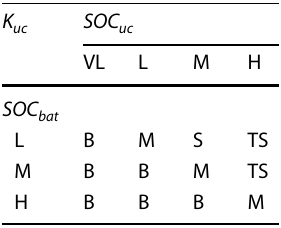
Table 5 Fuzzy rule table in discharging mode( P